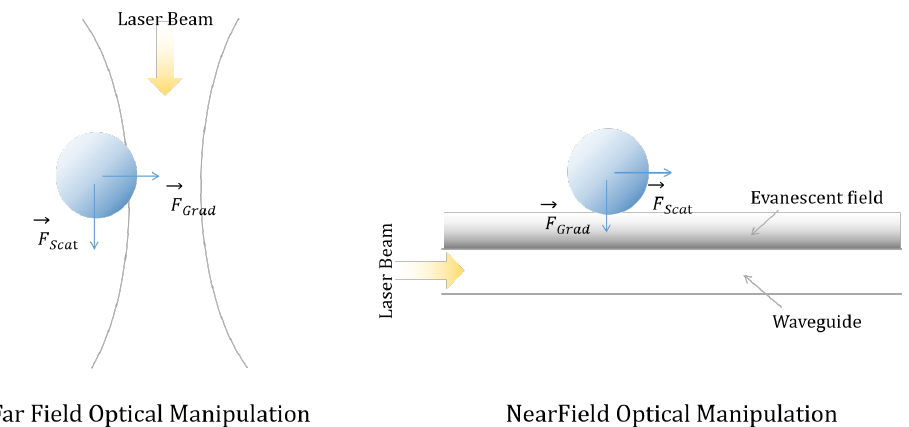
Figure 2. Schematic comparison between far field and near field optical manipulation.